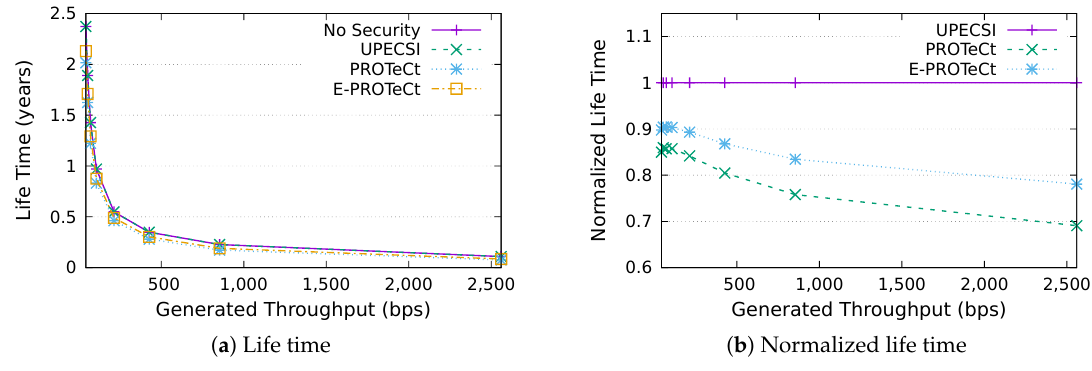
Figure 24. Life time analysis for an IoT network with 160